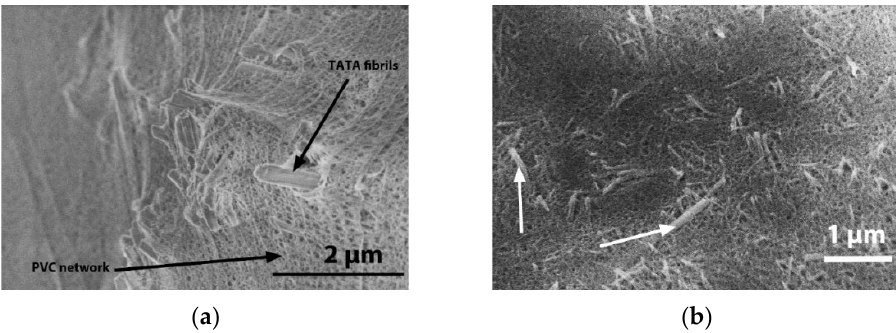
Figure 3. ( a ) SEM image of a hybrid PVC/TATA/bromobenzene gel. The PVC network and the TATA fibrils are indicated by black arrows. ( b ) SEM image of a hybrid PVC/TATA/tetrachloroethane gel. The PVC network and the TATA fibrils are indicated by white arrows.